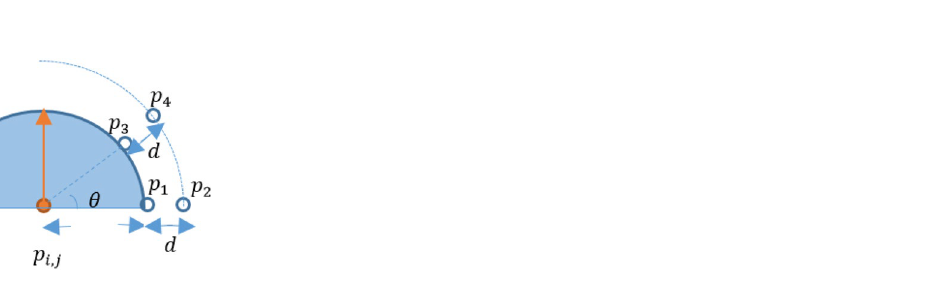
Figure 2. Example of a circle quarter and corresponding points along two certain